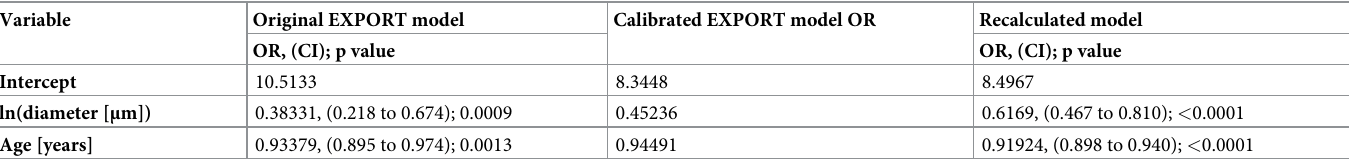
Table 2. Comparison of the multivariate logistic regression analyses for successful vitreomacular traction resolution.